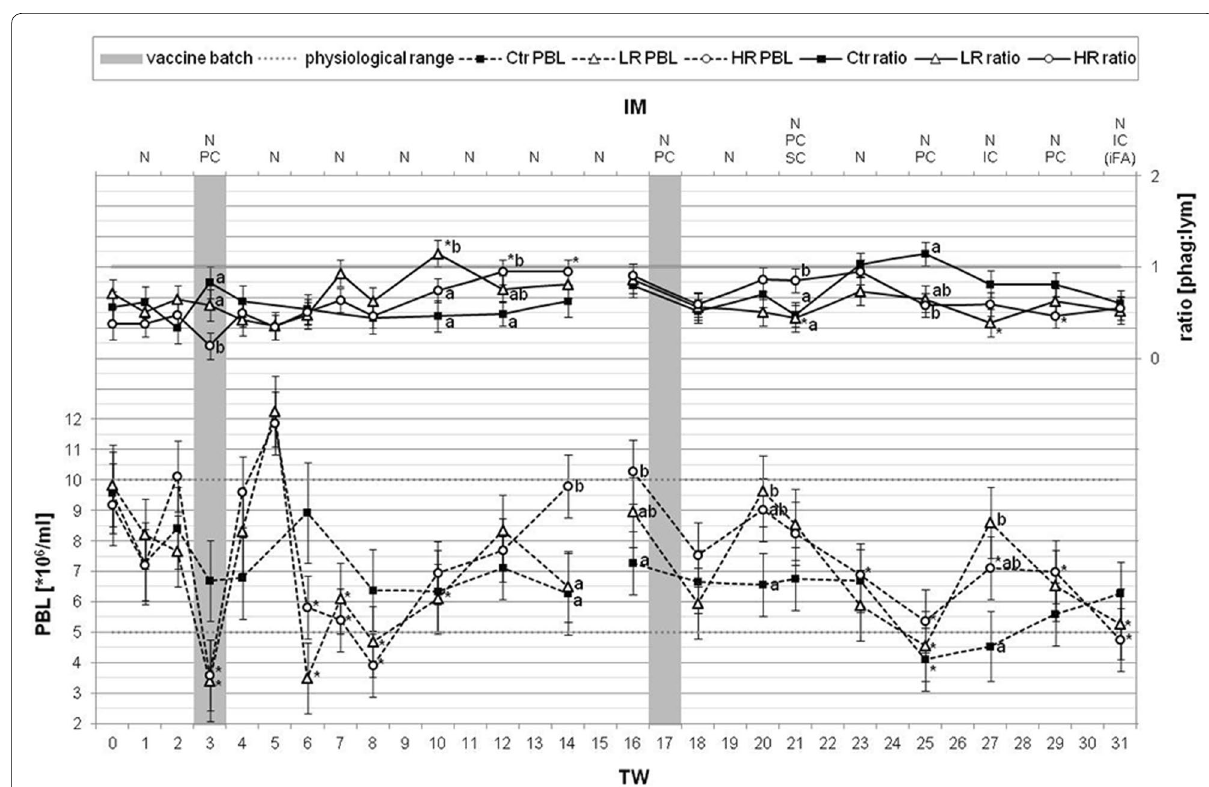
Fig. 2 Total PBL contents and the ratios of phagocytes to lymphocytes in blood. On the ordinates, the total PBL contents and the ratios of phagocytes to lymphocytes in blood are depicted as LSM SD for the three examined animal groups [(“Ctr” control animals (n 5), “LR” treated, ± = low responder animals (n 4), “HR” treated, high responder animals (n 5)]. The physiological range of PBL (5 up to 10 million leukocytes per = = milliliter blood) was accented by two gray dotted lines. The 31-week treatment period (TW) is depicted on the lower abscissa. The upper abscissa indicates the different application routes [(nasal (N), percutaneous (PC), subcutaneous (SC) and intracutaneous (IC)] of the vaccines to the TWs with immunization (IM). Only once, incomplete Freund’s adjuvant (iFA) was supplemented to the MucoCD - I vaccine. The gray bars in TWs 3 and 17 highlight the times of the first uses of the vaccine batches A and B, respectively. During the treatment periods with both vaccine batches and the particular TW before the first use of vaccine batch A or B, substantial differences within the same group are marked by asterisks ( p < 0.05). Lower case (a, b, c) label evident differences ( p < 0.05) between the groups at the same